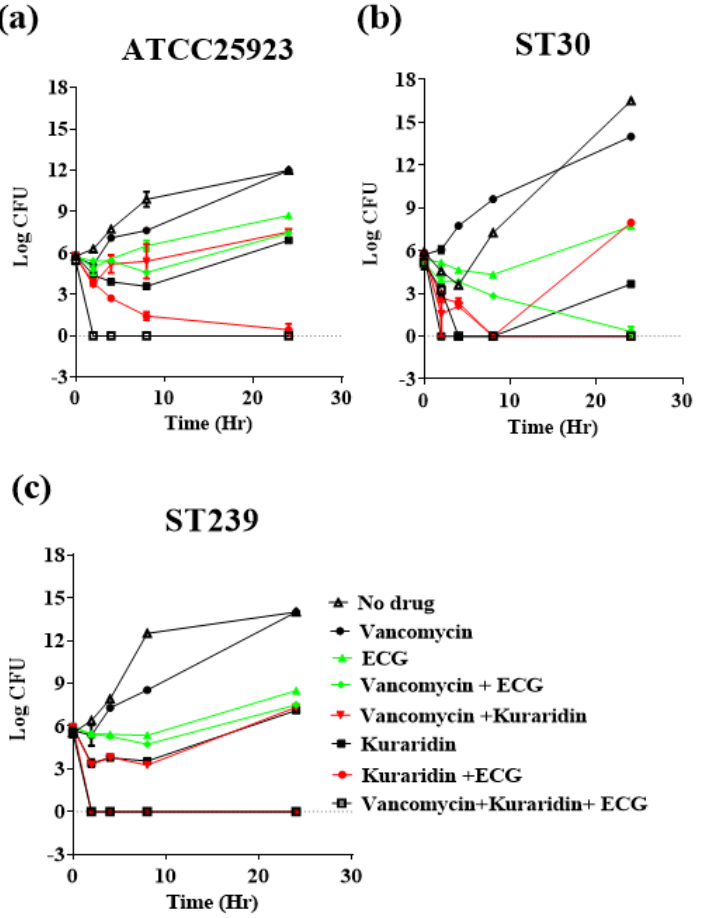
Figure 1. In vitro time-kill curves ( a ) ATCC25923, ( b ) ST30 and ( c ) ST239; epicatechin gallate (ECG) (2 µ g/mL), kuraridin (2 µ g/mL), and vancomycin (0.5 µ g/mL) alone and in combination. Results are expressed as log CFU/mL and are given as mean ± standard error of mean (n = 3). 2.3. ECG and Kuraridin Are Non-Cytotoxic and Could Dose Dependently Inhibit Inflammatory Cytokines Released from Peptidoglycan-Induced and Staphylococcal-Enterotoxin-B-Induced Human Peripheral Blood Mononuclear Cells (PBMC) Bacterial infections are usually associated with inflammatory cytokines production from immune cells. Hence, the anti-inflammatory effects of ECG and kuraridin on the production of IL-1 β , IL-6 and TNF- α stimulated by S. aureus isolated peptidoglycan (PGN) and Staphylococcal enterotoxin B (SEB) on human PBMC were investigated. The concentrations of IL-1 β , IL-6 and TNF α produced from PGN-stimulated PBMC were 3350 ± 309.6, 58,956 ± 5441 and 4049 ± 92.2 pg/mL, respectively. Kuraridin could also dose-dependently inhibit the production of inflammatory cytokines IL-1 β , IL-6 and TNF α s from SEB-stimulated PBMC (Figure 2a). ECG (32–64 µ g/mL) could inhibit IL-1 β and IL-6 productions from PGN-stimulated PBMC (Figure 2a) but not TNF α production.